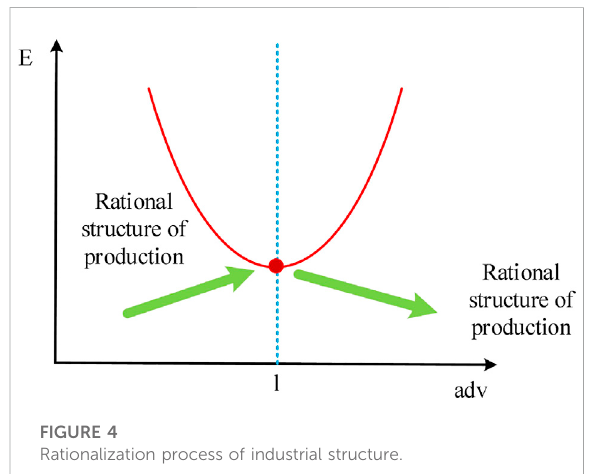
FIGURE 4 Rationalization process of industrial structure.